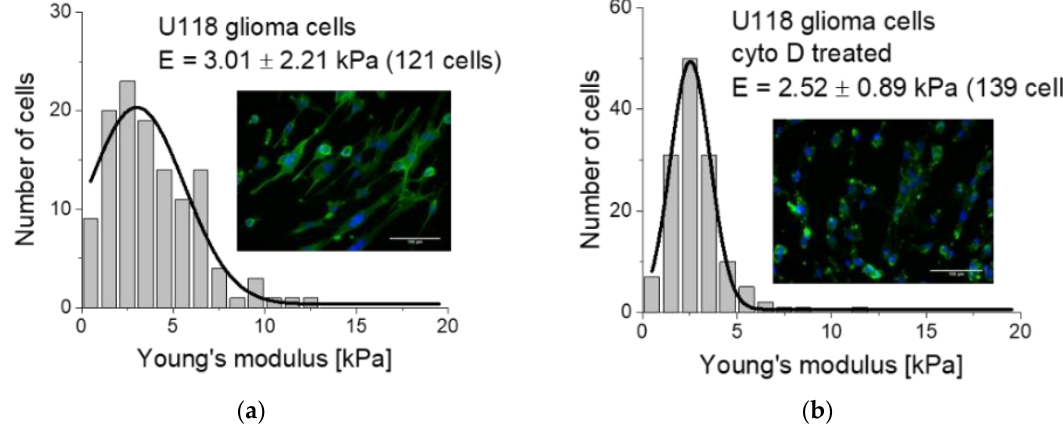
Figure 3. Nanomechanical properties of glioma U118 cells ( a ) before and ( b ) after the treatment with cytochalasin D (cyto D, 5 µg/mL, 10 min). Cytochalasin D induces a softening of the cells linked with reorganization (depolymerization) of the actin filaments. Insets: Images showing actin filaments stained fluorescently with phalloidin Alexa Fluor 488 dye.